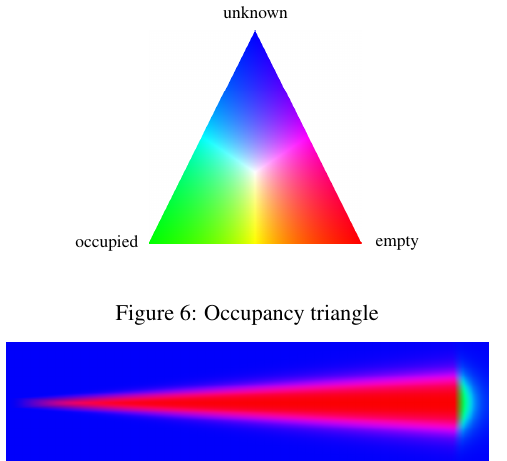
Figure 7: Laser beam (the cone angle is exaggerated for illustra- tive